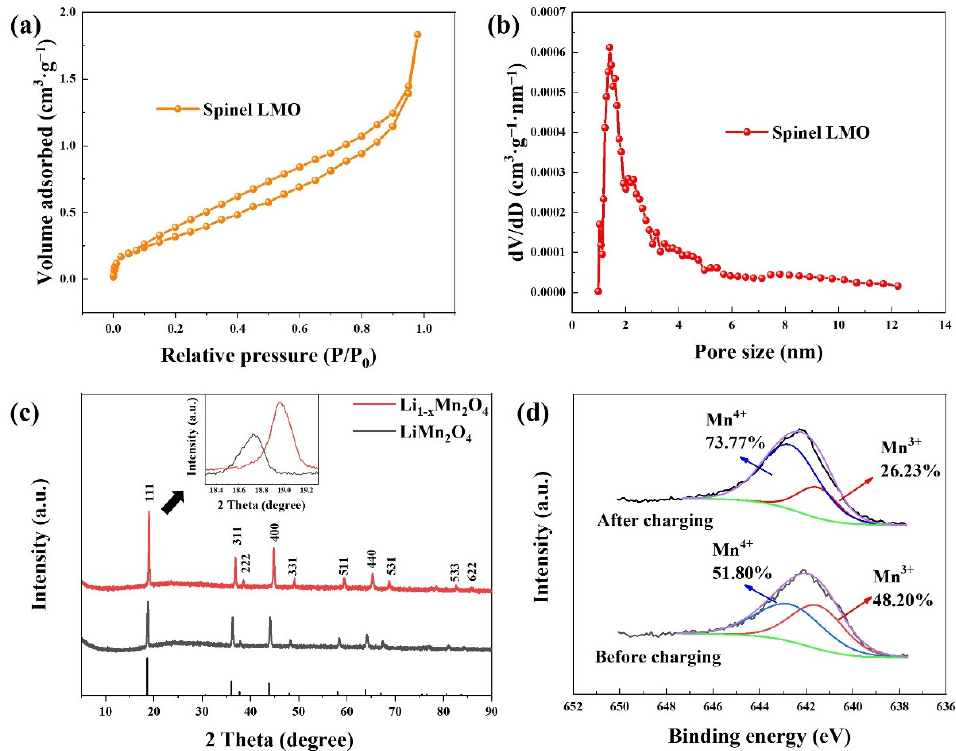
Figure 4. ( a ) N 2 adsorption/desorption curve and ( b ) pore size distribution of the LiMn 2 O 4 material; ( c ) the XRD patterns of the spinel LMO electrode and ( d ) the XPS profiles of Mn 2p 3/2 before and after the deionization process.